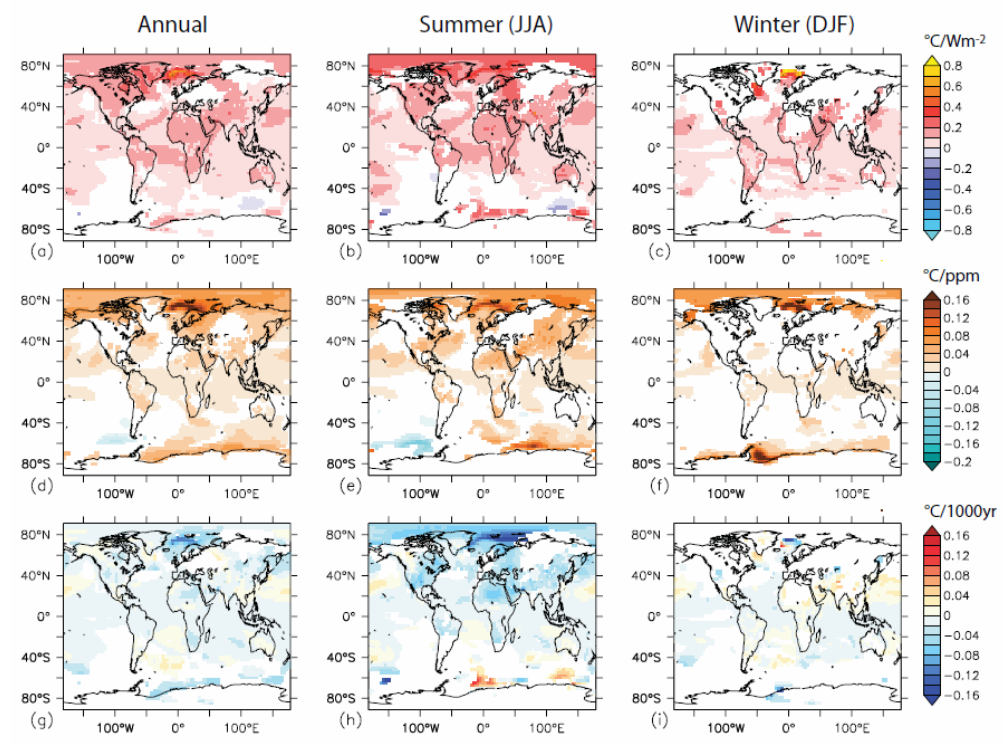
Figure 6 : first order sensitivity of the temperature in SGI to TSI variability estimated by C BV °C/Wm -2 (a,b,c,), to CO 2 by C BV expressed in ◦ C/ppm (d, e, f) , and slope of the ε 3 residuals corresponding to C 3 expressed in ◦ C/1000yr (g, h, i) . Those coefficients are calculated for annual (a, d, g), summer (b, e, h, June-July- August) and winter (c, f, i, December-January-February) averages. The white areas represent the grid points where the coefficients are not significant at 99.5% (Student t test).